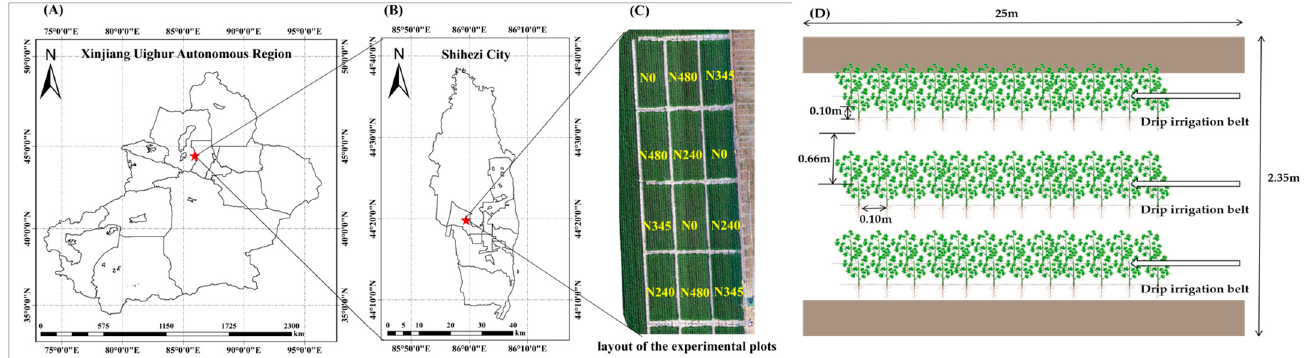
Figure 1. Overview map of study area and layout of the experimental plots. ( A ) Location of the pilot area in Xinjiang Uighur Autonomous Region, ( B ) Location of the pilot area in Shihezi City, ( C ) layout of the experimental plots, ( D ) Layout of row spacing in the test plot.